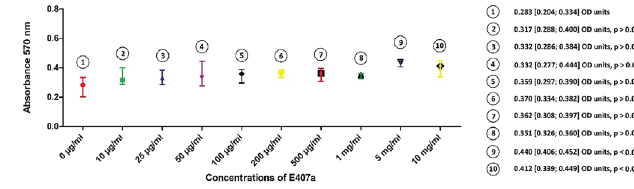
Figure 4 - The metabolic activity of dermal fibroblasts treated with semi-refined carrageenan (E407a) for 24a (0-10 mg/ml of the food additive) was estimated quantitatively using MTT assay. Numerical values are expressed in optical density (OD) units. Exposure to E407a at a concentration of 5 mg/ml and higher statistically significantly increased the metabolic activity of fibroblasts compared with control samples.